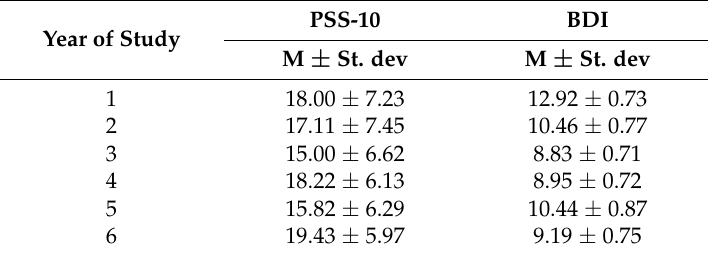
Table 5. Results for PSS-10 and BDI per year of study.